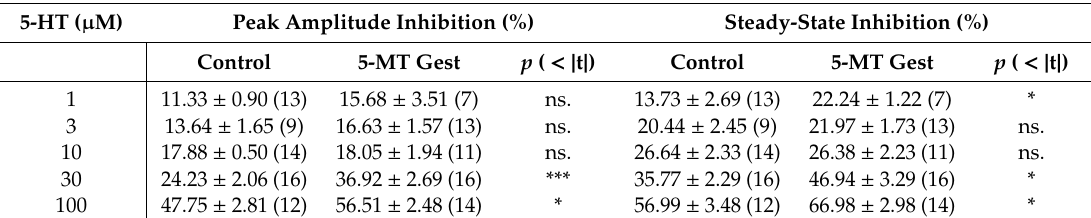
The number of recorded cells for each 5-HT concentration and group are displayed between the parentheses. Significance codes: p < 0.001 (***), p < 0.01 (**), p < 0.05 (*), p > 0.05